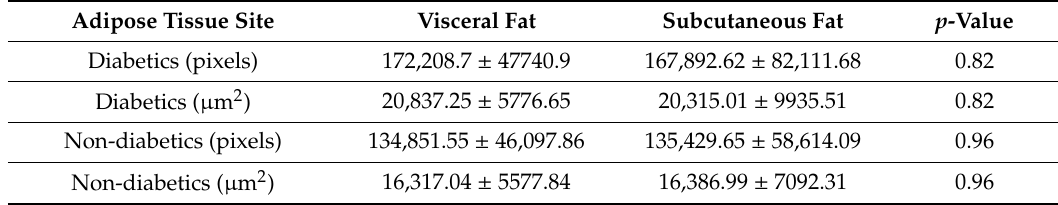
Table 10. Comparison of visceral and subcutaneous adipocyte cell size in diabetics and non-diabetics.